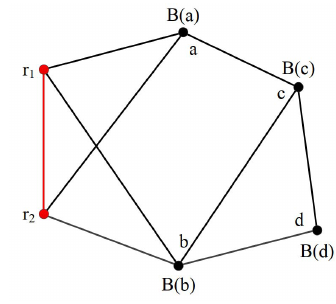
Figure 3. MUWSN network and beacon plane.